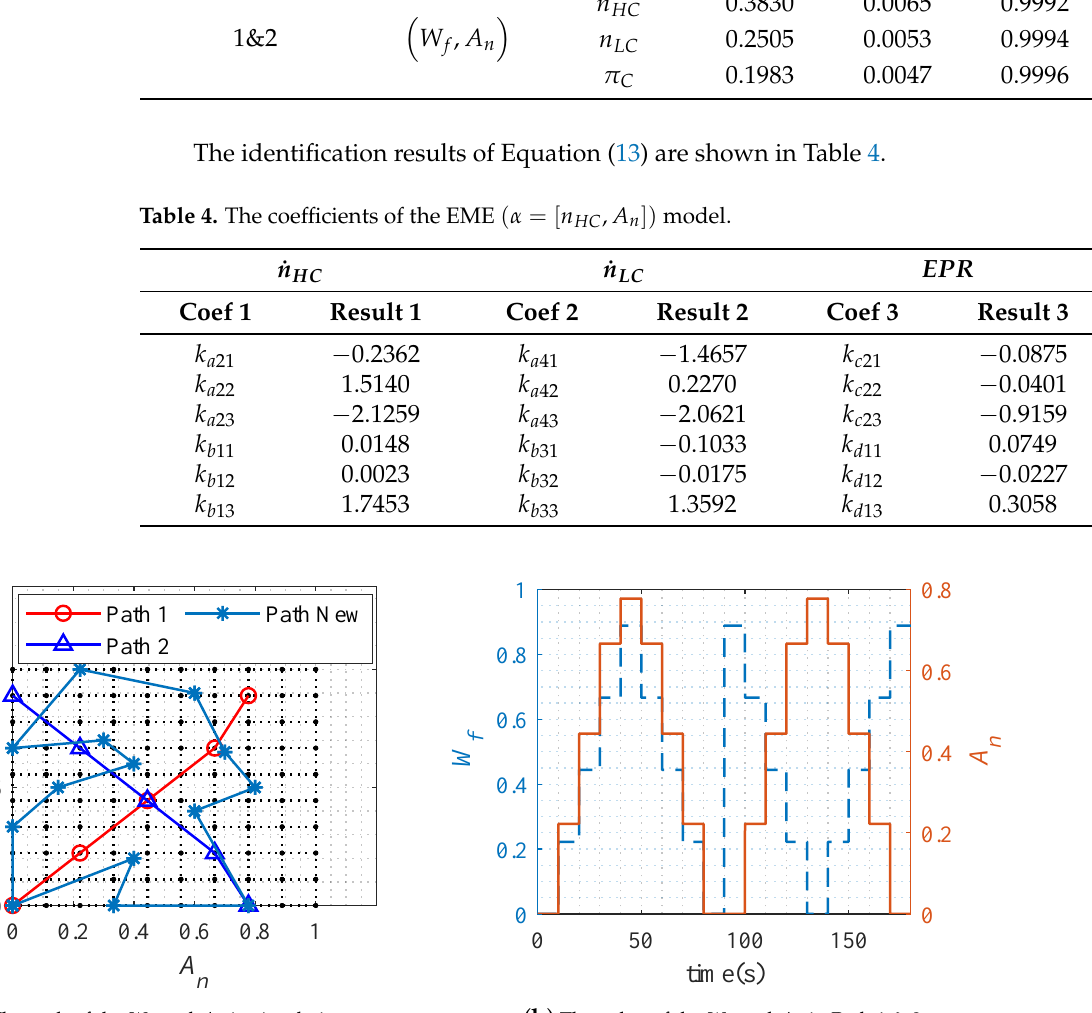
Figure 8. The input variables W f and A n for the identification of the EME